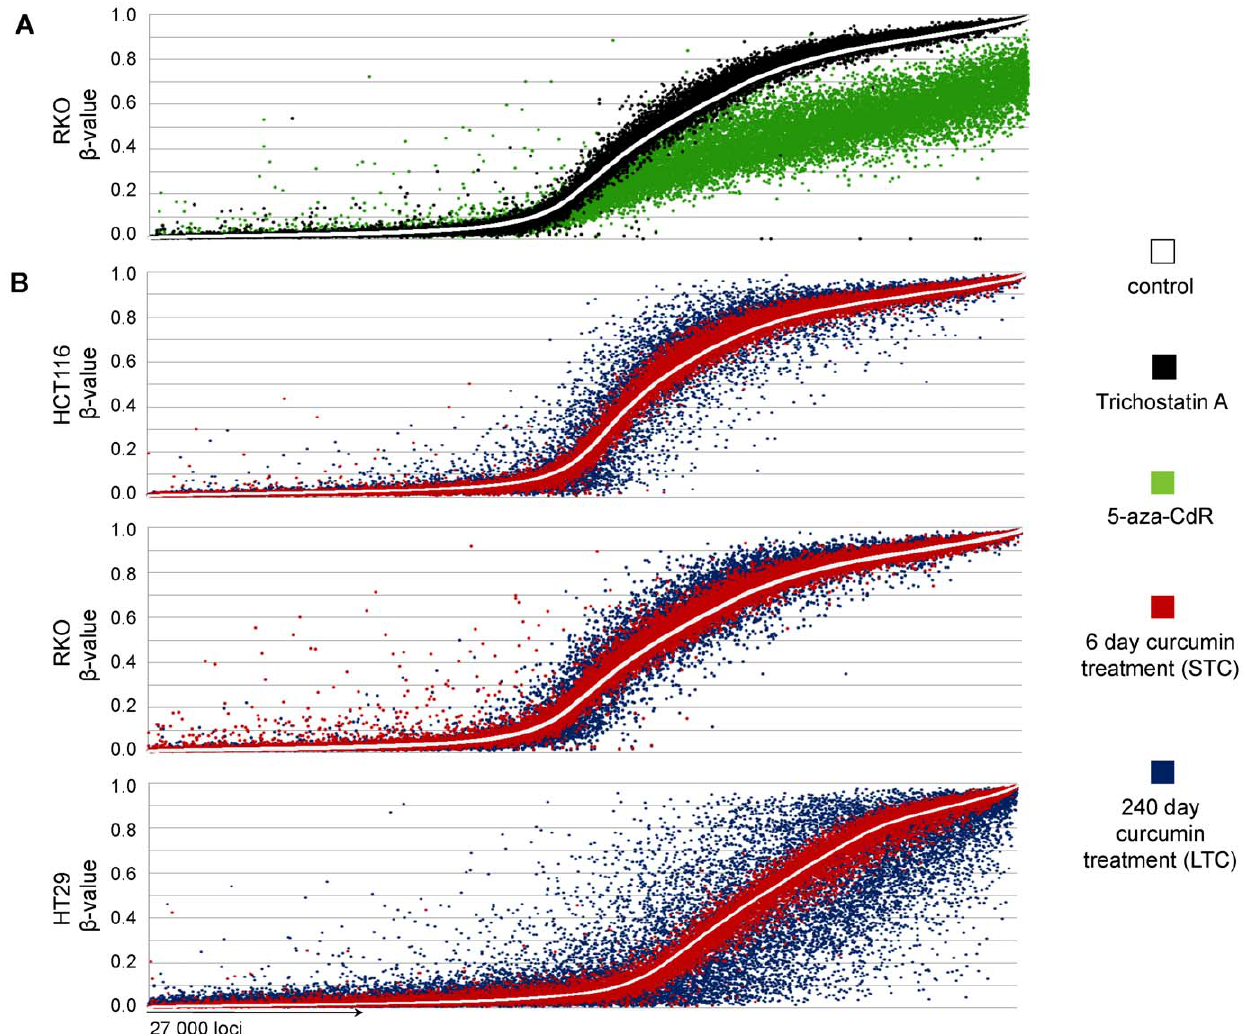
Figure 2. Modification of multiple CpG loci following treatment of CRC cells with curcumin. (A) For the positive control of hypomethylation, we treated RKO cells with 2.5 m M 5-aza-CdR. For the negative control, RKO cells were treated with 0.3 m M trichostatin A (TSA). (B) Three CRC cell lines from different epigenetic phenotypes were treated with effective anti-proliferative concentrations of curcumin (HCT116 7.5 m M, RKO and HT29 10 m M) for 6 and 240 days. Short treatment was associated with few changes in DNA methylation, while long-term treatment with curcumin resulted in extensive changes in CpG methylation. To compare the direct effect of the treatment on the methylation status Db ( b control– b treatment) values were calculated accordingly for each CpG locus. The white line represents the ascending order of methylation of CpG loci in control/ parental cell lines. Dots represent the direct comparison of matching CpG loci ( . 27,500) in treated